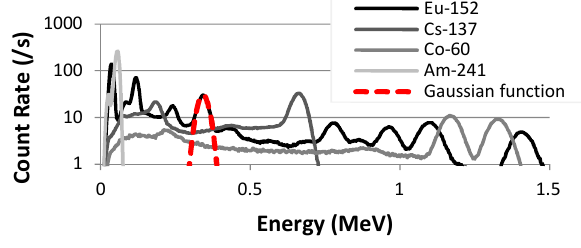
Fig 1. Gamma spectra fitting with a Gaussian function.